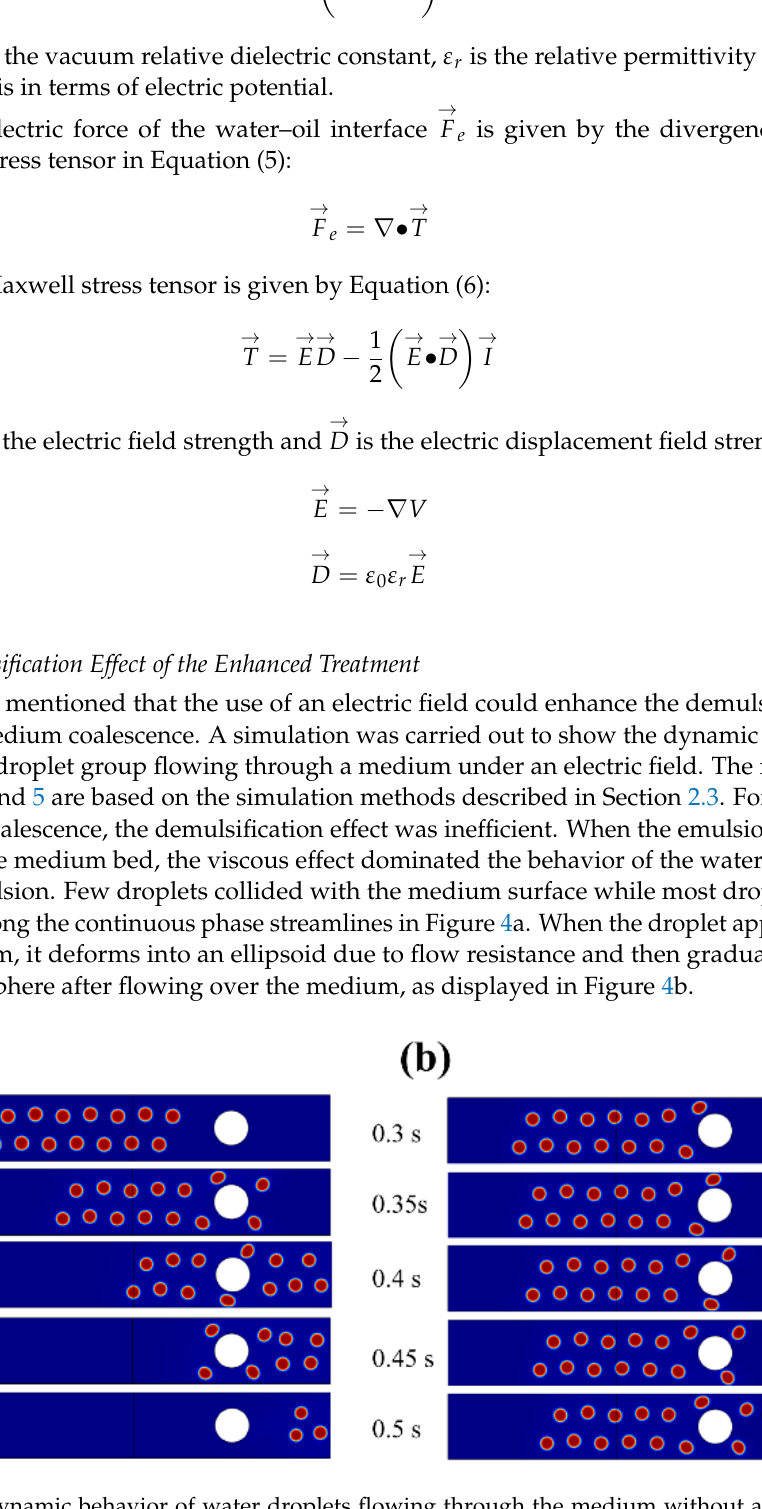
Figure 4. Dynamic behavior of water droplets flowing through the medium without an applied electric field. ( a ) The whole process. ( b ) The specific behavior of droplet near the medium.